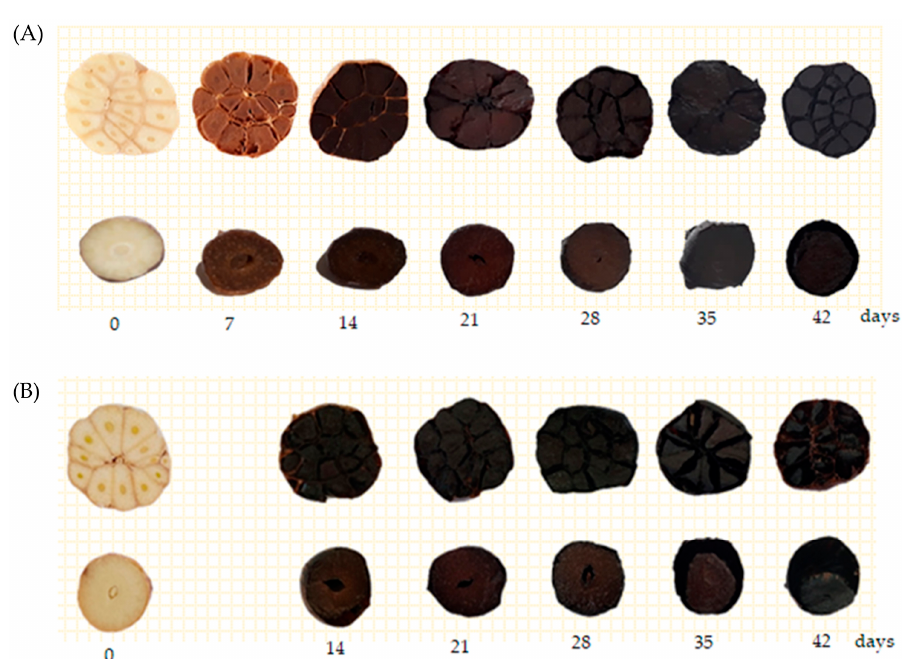
Figure 1. Changes in the color of Thai fresh garlic strain and Chinese garlic strain during period of thermal processes methods; ( A ) temperature was set at 70 °C, 80 % RH, 42 days and ( B ) temperature was set at Step 1 : 75 °C, 85 % RH for 9 days. Step 2 : 70 °C, 80 % RH for 1 days; Step 3 : 60 °C, 80 % RH for 21 days.